Question: Based on the figure, does the quantity rise or fall?
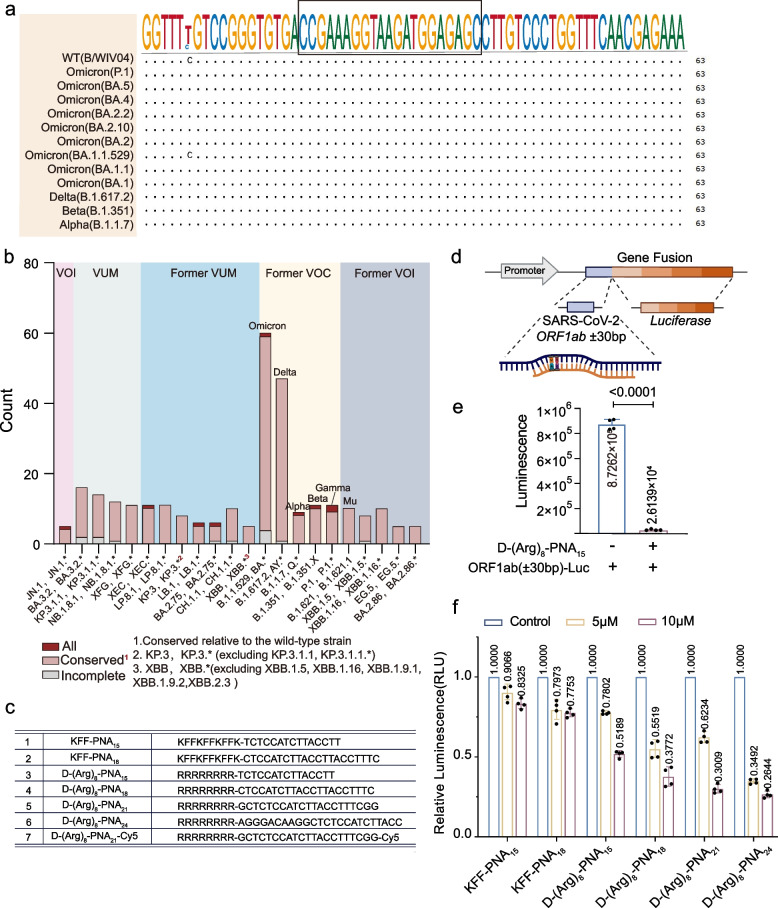
Answer: increasing